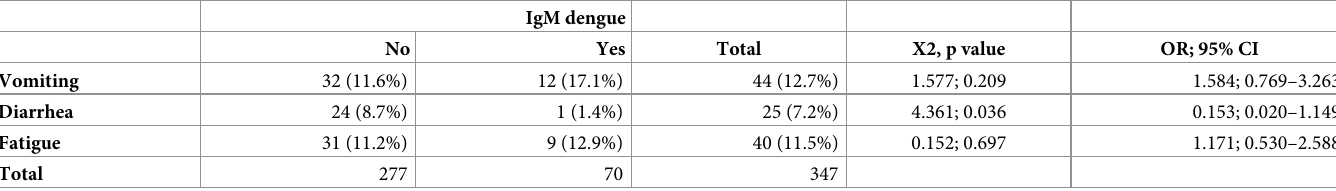
Table 5. Occurrence of specific symptoms among actively dengue infected compared to non-infected